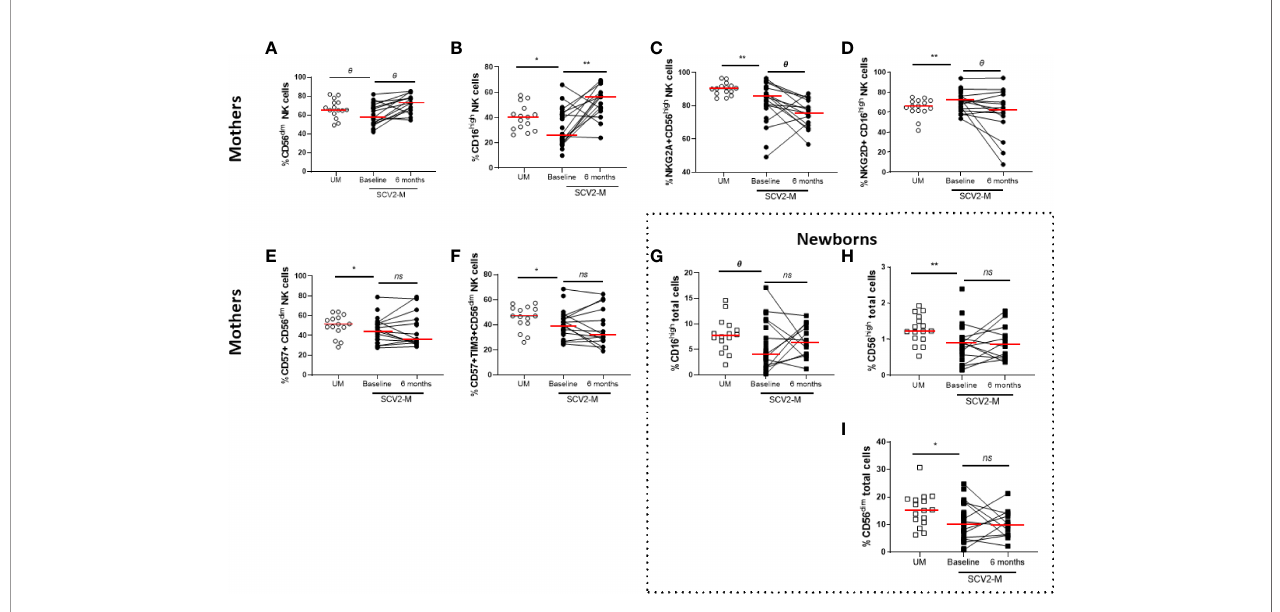
FIGURE 2 | Frequency of NK cell subsets, activation and inhibition receptors and maturation markers. Differences at baseline and 6 months later. Frequency of CD56 dim and CD16 high NK cell subsets in mothers (A, B) . NKG2A, NKG2D expression in CD56 high and CD16 high NK cell subsets, respectively (C, D) ; CD57 and CD57, TIM3 co-expression in CD56 dim NK cell subsets (E, F) . Frequency of CD16 high , CD56 high and CD56 dim total cells in newborns (G – I) . Mann-Whitney U-test was used to compare groups. Wilcoxon test was conducted to compare paired events. SCV2-M, SARS-CoV2 mothers ’ group; UM, Uninfected mothers ’ group. **p ≤ 0.01, *p<0.05, Ɵ 0.05 ≤ p ≤ 0.1, ns p>0.1